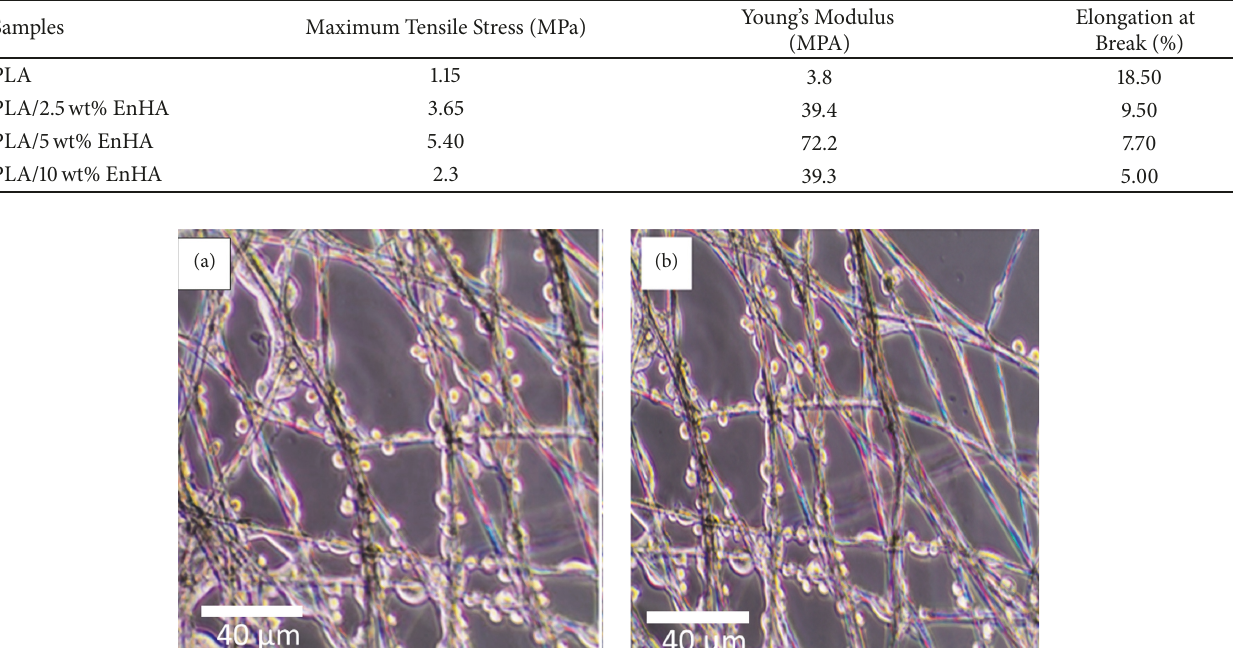
Table 2: Tensile properties of PLA/EnHA fibers.